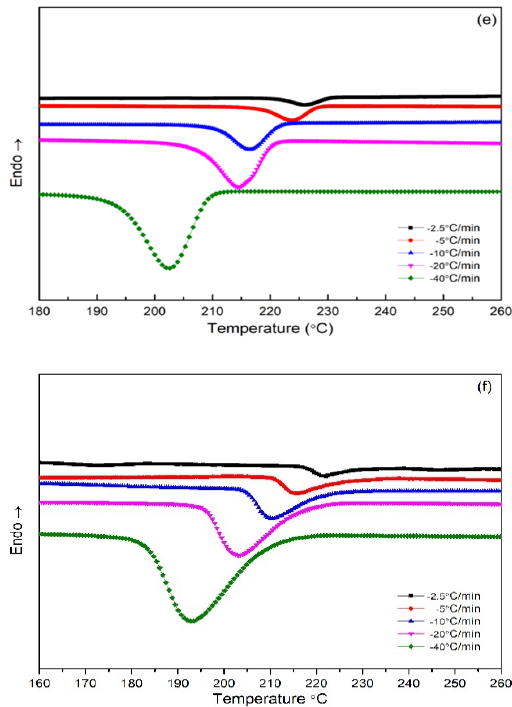
Figure 9. Heat flow versus temperature during nonisothermal crystallization of ( a ) PA56, ( b ) CoPA-1,